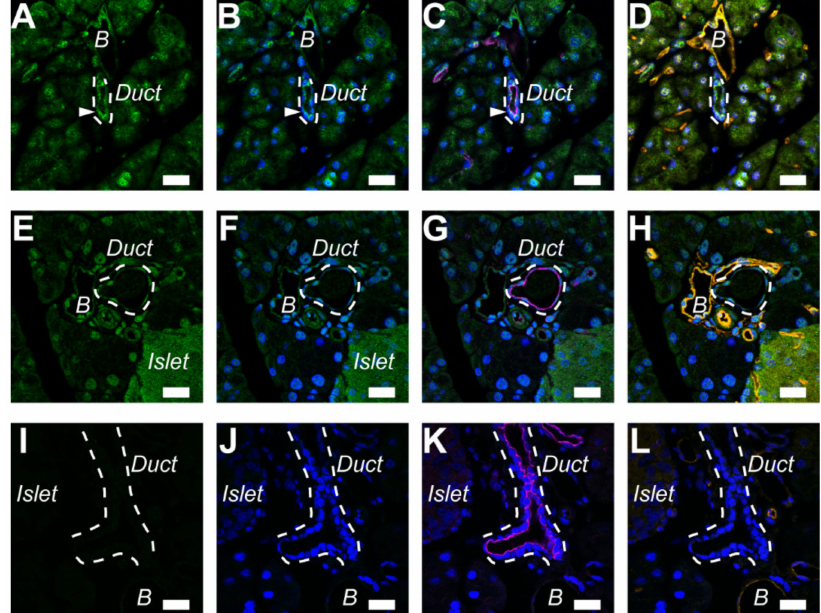
Figure 3. Immunolocalization of A 2A adenosine receptors in the pancreatic duct of the mouse. ( A ) Fluorescence of A 2A adenosine receptor in the luminal membrane of duct cells (arrowhead). The broken lines indicate a duct. The signal was detected in the endothelial cells of blood vessels (B). ( B ) Overlay of A and nuclear staining with DAPI (blue). ( C ) Overlay of B and fluorescence image of ezrin (purple). ( D ) Overlay of B and fluorescence image of a blood vessel marker (orange: platelet endothelial cell adhesion molecule-1, or PECAM-1) in the same sample. ( E ) The signal for the A 2B adenosine receptor was detected in the blood vessels (B) and islet. The broken line indicates a duct. ( F ) Overlay of E and nuclear staining. ( G ) Overlay of F and fluorescence image of ezrin (purple). ( H ) Overlay of F and fluorescence image of PECAM-1 (orange). ( I ) Isotype control image of the mouse pancreas with normal rabbit IgG (2 µ g / mL). ( J ) Overlay of I and nuclear staining. ( K ) Overlay of J and fluorescence image of ezrin (purple). ( L ) Overlay of J and fluorescence image of PECAM-1 (orange). Representative images of three mice are shown. Bars = 20 µ